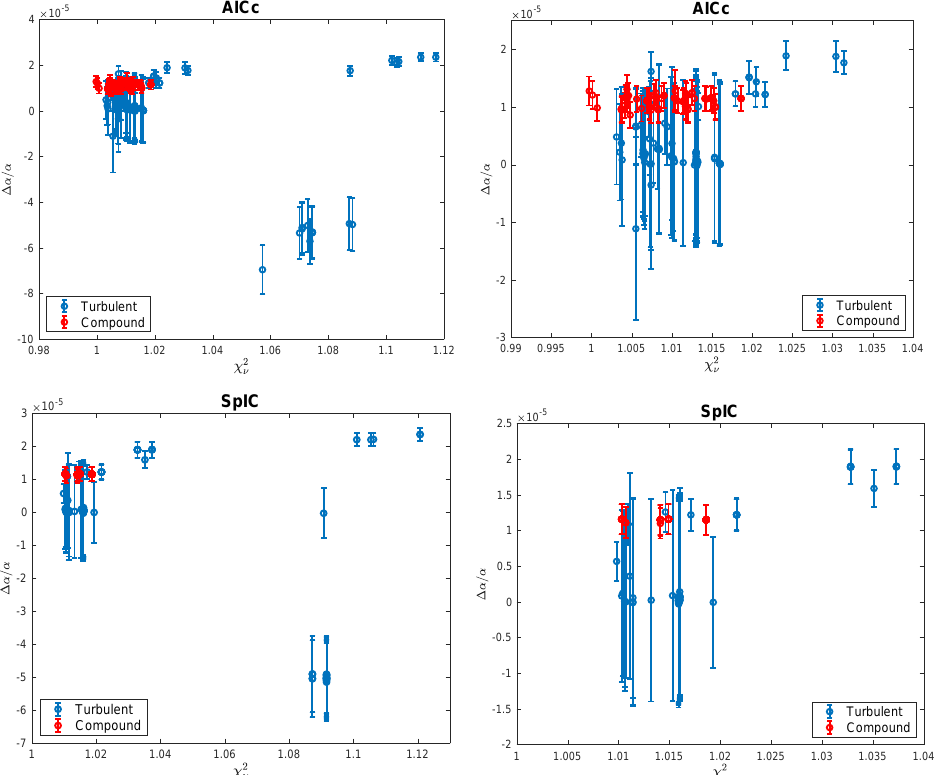
Figure 6. Plots of ∆ α / α vs. χ 2 ν for the 4 combinations of AICc, SpIC, turbulent, and compound. Distortion-blinding was applied to the turbulent (blue) points but not the compound (red) points. See Section 4.2. The two right hand panels are zoom-ins of the two left hand